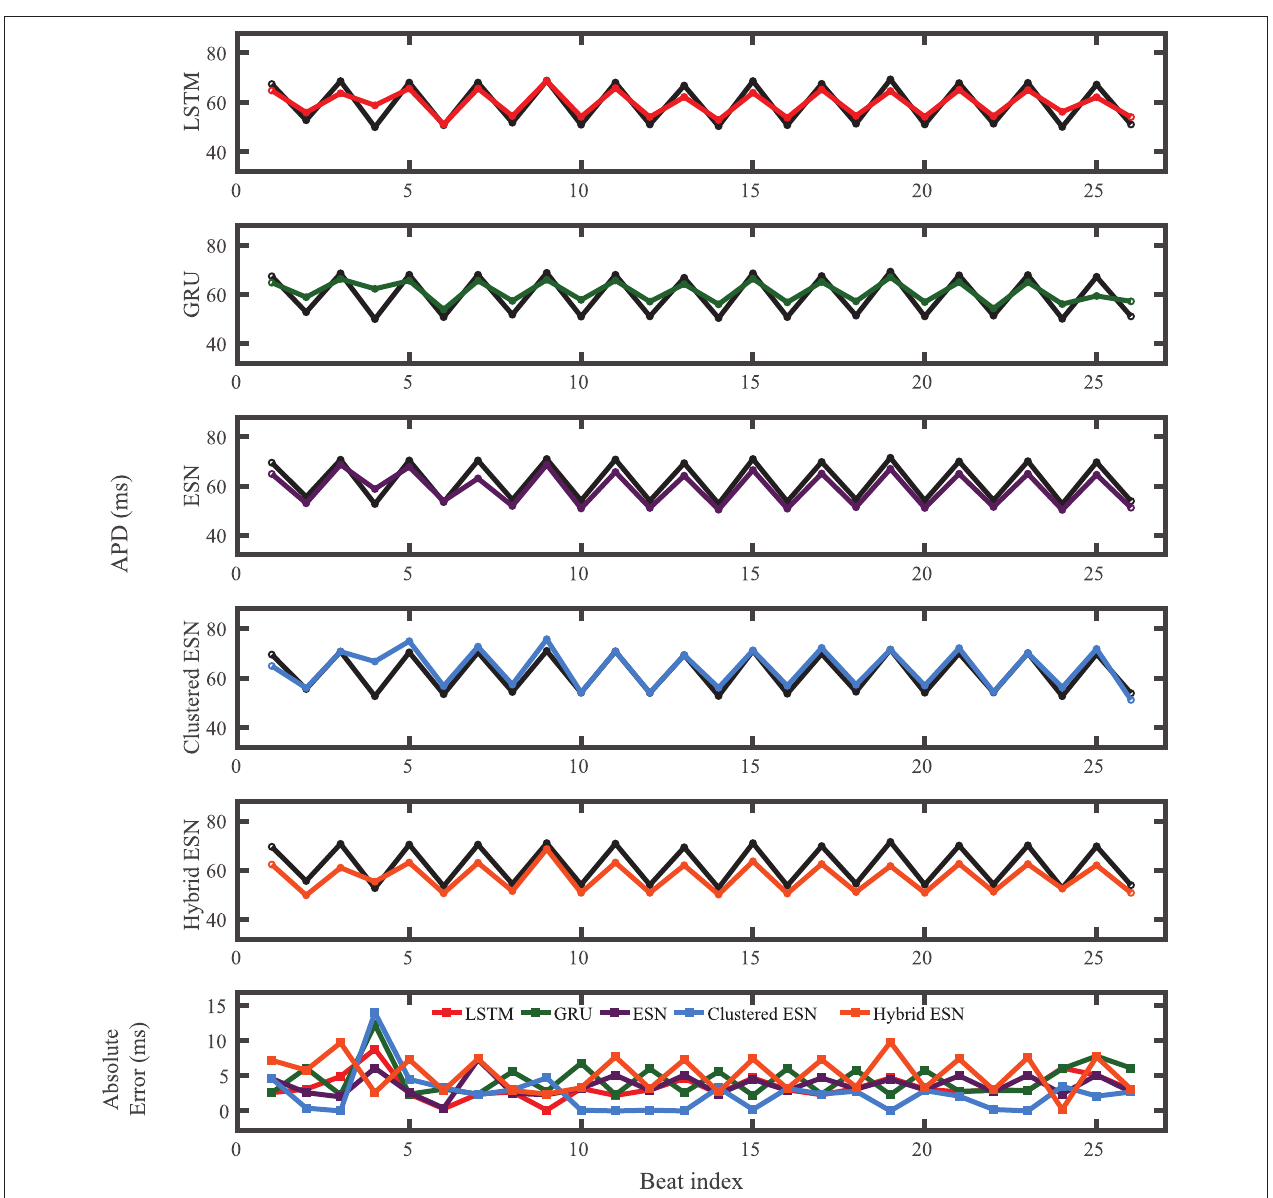
FIGURE 11 | Experimental dataset APD prediction results obtained for the five methods using a fixed network size of 100 neurons. APDs from data used for testing are shown in black for reference and predicted APDs are shown in color. Absolute error in APD prediction is shown in the bottom subplot, with color corresponding to prediction